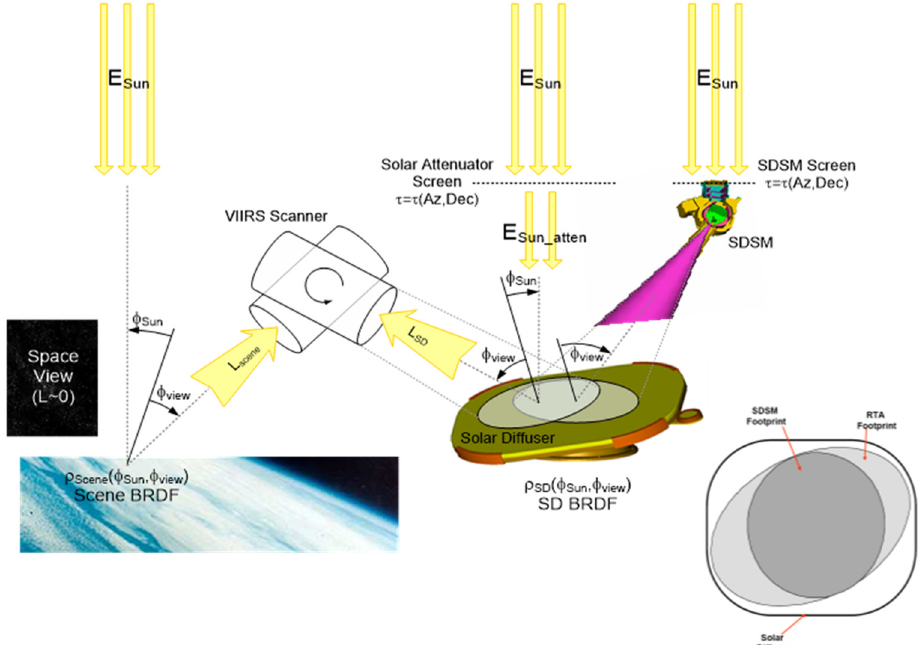
Figure 3. Diagram of the VIIRS solar diffuser calibration. This includes the VIIRS scanner that looks at the Earth and solar diffuser (SD) when illuminated by the Sun through an attenuation screen and the solar diffuser stability monitor (SDSM) that views the Sun through a screen and the SD while it is illuminated.